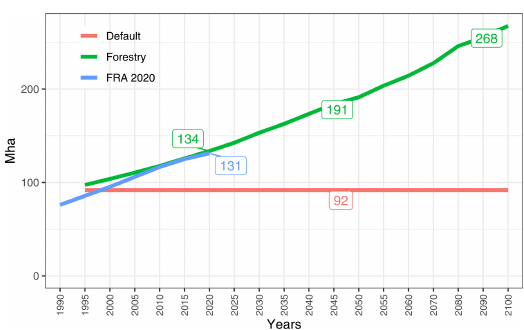
Figure 11. Development of plantation area for 1995–2100 at the global level in the default and forestry scenarios. The flat line in the default scenario is due to the assumption of static plantations at 1995 levels. Historical numbers are from the Forest Resources Assessment Report (FRA) 2020 (FAO,